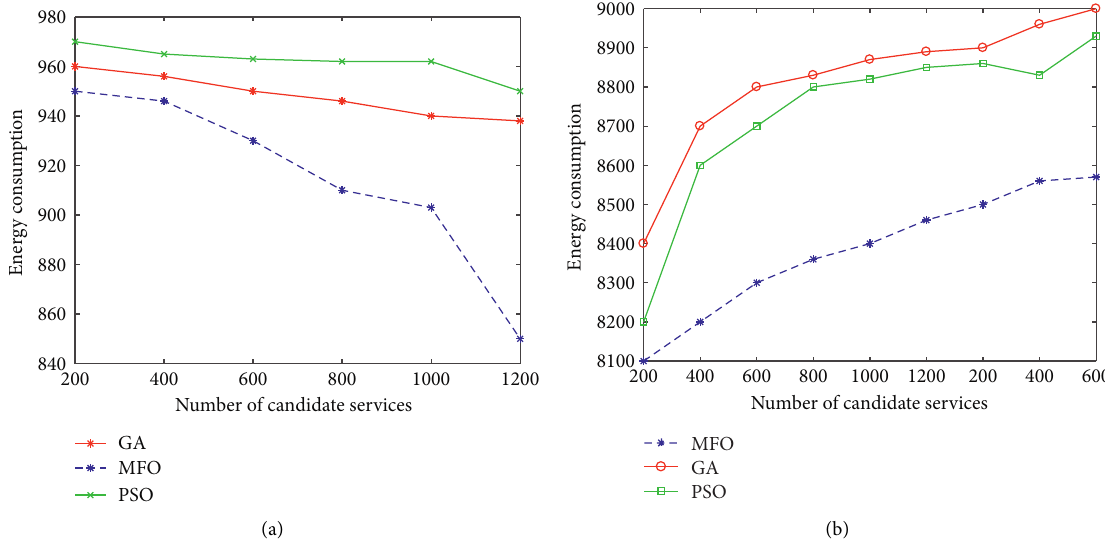
Figure 6: Relationship between energy consumption and services quantity. (a) Energy consumption under services quantity. (b) Energy consumption under different service